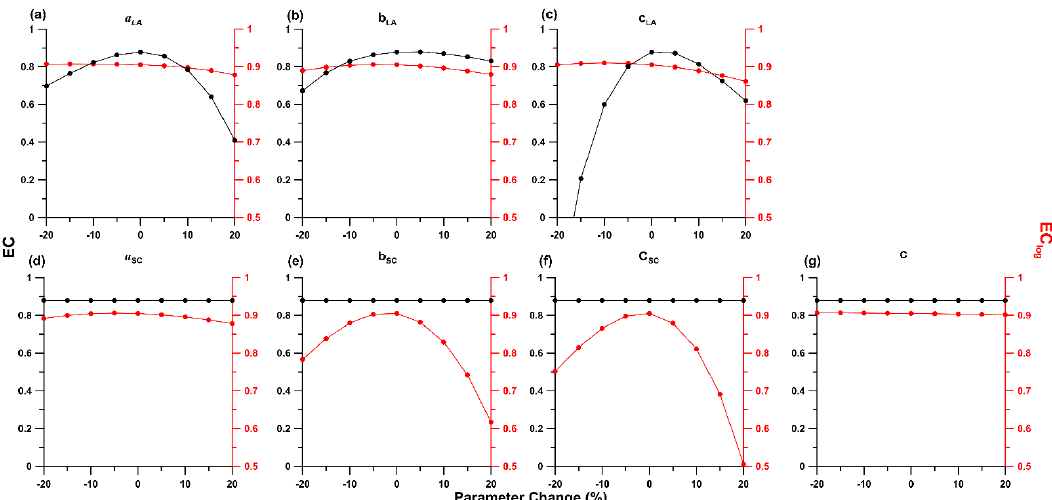
Figure 7. Sensitivity analysis for the parameters of ( a ) a LA , ( b ) b LA , ( c ) c LA , ( d ) a sc , ( e ) b sc , ( f ) c sc , and ( g ) C. Each plot shows the adjustment of the target parameter by +/ − 20% while leaving the other 6 parameters unchanged. The black lines represent the responses of the performance (EC) of the landslide model to the changes of the parameter values, and so do the red lines but for the performance (EC log ) of the sediment transport model.